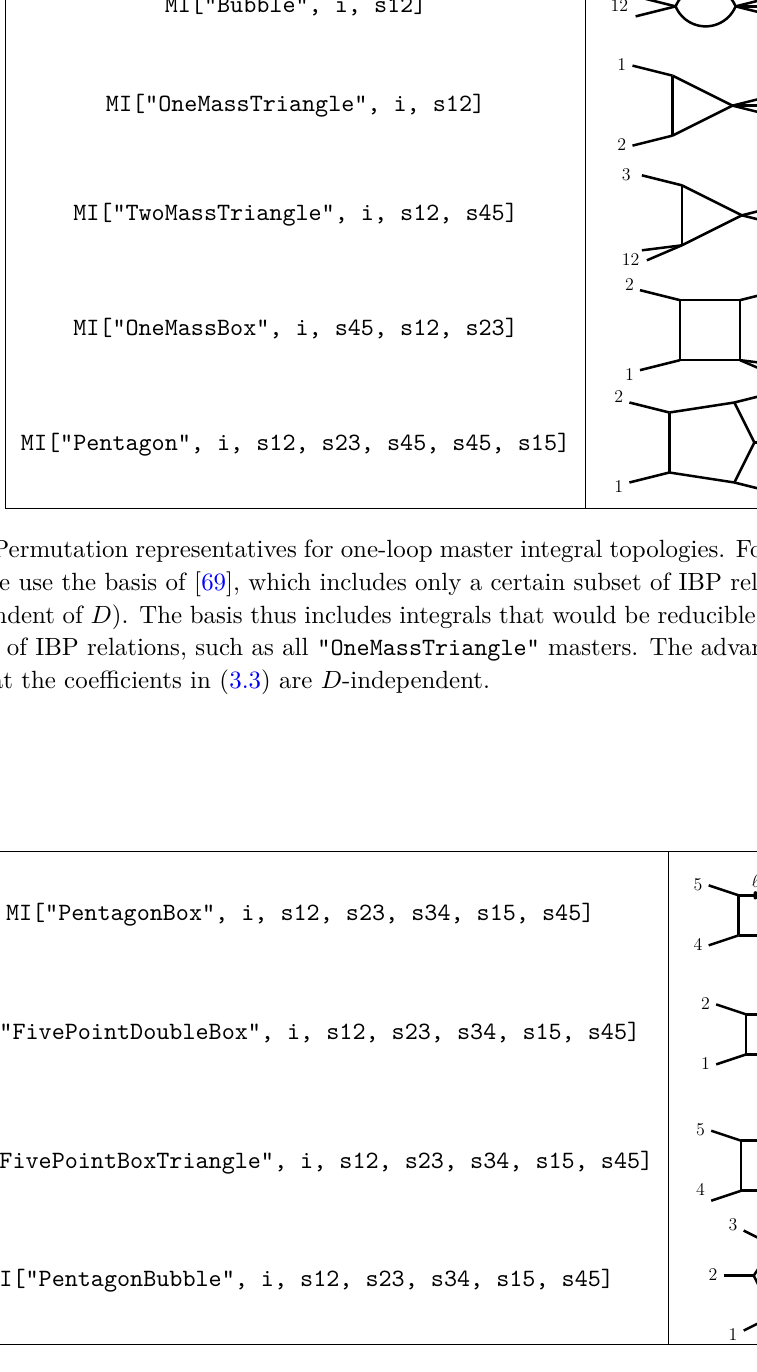
Table 9. Permutation representatives for five-point two-loop master integral